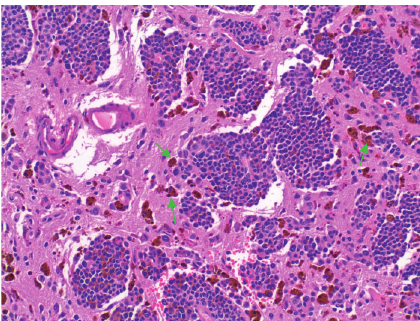
Figure 3: Brain biopsy. Glial tissue infiltrated by neoplastic melanocytic cells showing focally a perivascular pattern (see arrows). These cells show moderate pleomorphism, few mitoses, and focal melanin